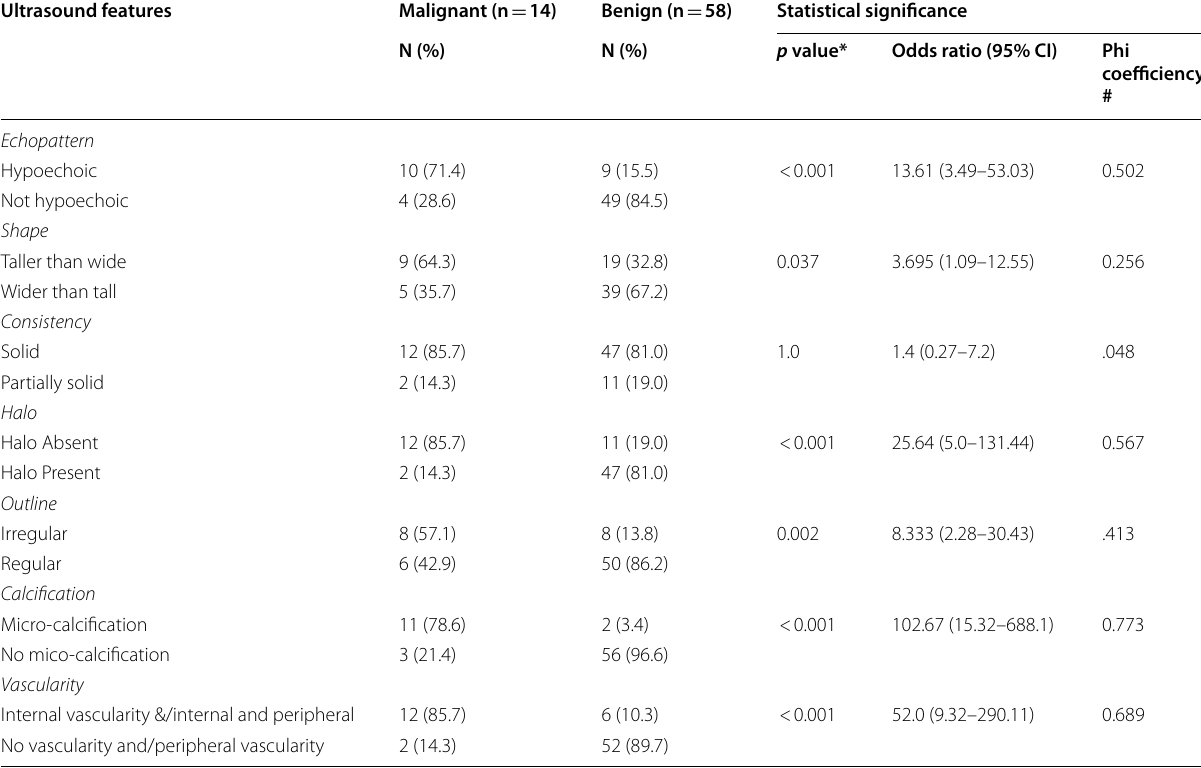
*Fisher exact test was used as some expected cell values were less than 5